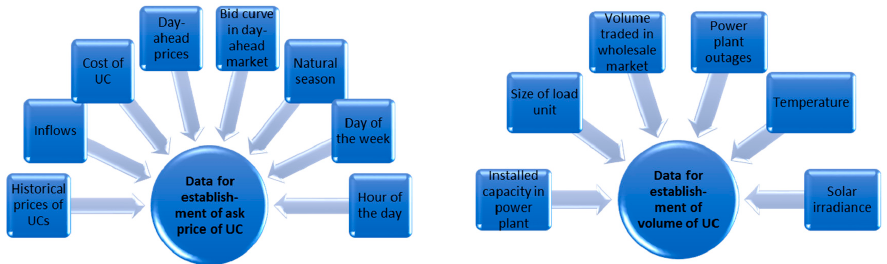
Figure 9. Secondary data requested for the establishment of initial Merit Order list.